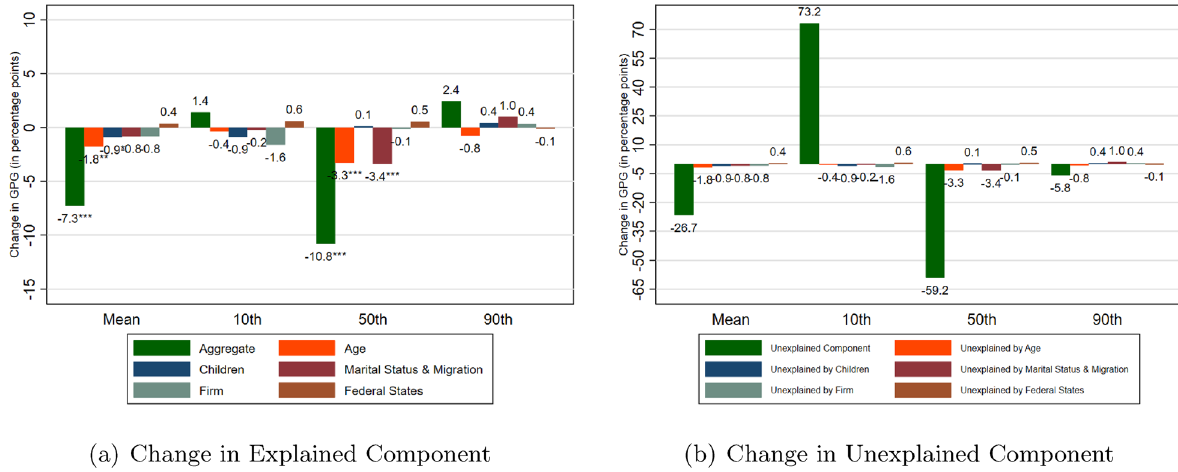
Fig. 2 Detailed double decomposition of changes in the gender pay gap 2020‑1984 at the mean and selected percentiles and remaining sets of controls. Estimation based on approach outlined in Sects. 3 and 4. Men in 1984 are used as reference category. Aggregate refers to the change in the aggregate explained (panel ( a )) or unexplained (panel ( b )) component. Age, Children, Marital Status & Migration and Firm, Federal States are the changes in the corresponding parts (explained or unexplained) attributable to these sets of regressors. Age includes age dummies, Children includes dummies for having at least one child, for having at least one child below three years and between three and six years, respectively, Firm 1999 employees) firms. p < 0.01 , p < 0.05 , p < 0.1 . Robust standard errors for the includes small ( < 200 employees) and medium ( 200 − ∗ ∗ ∗ ∗ ∗ ∗ mean and bootstrapped standard errors across the distribution (500 replications) are used. SOEP sample weights used. Source: SOEP